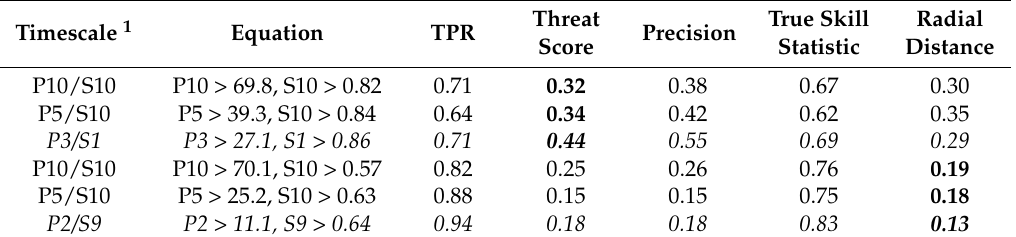
Table 1. Selected iterations of different threshold formats for the Seattle-Everett railway, illustrating improved performance for different skill metrics. Skill metric used for optimization is in bold text, optimal threshold equation and statistics for the two different optimizations are italicized .